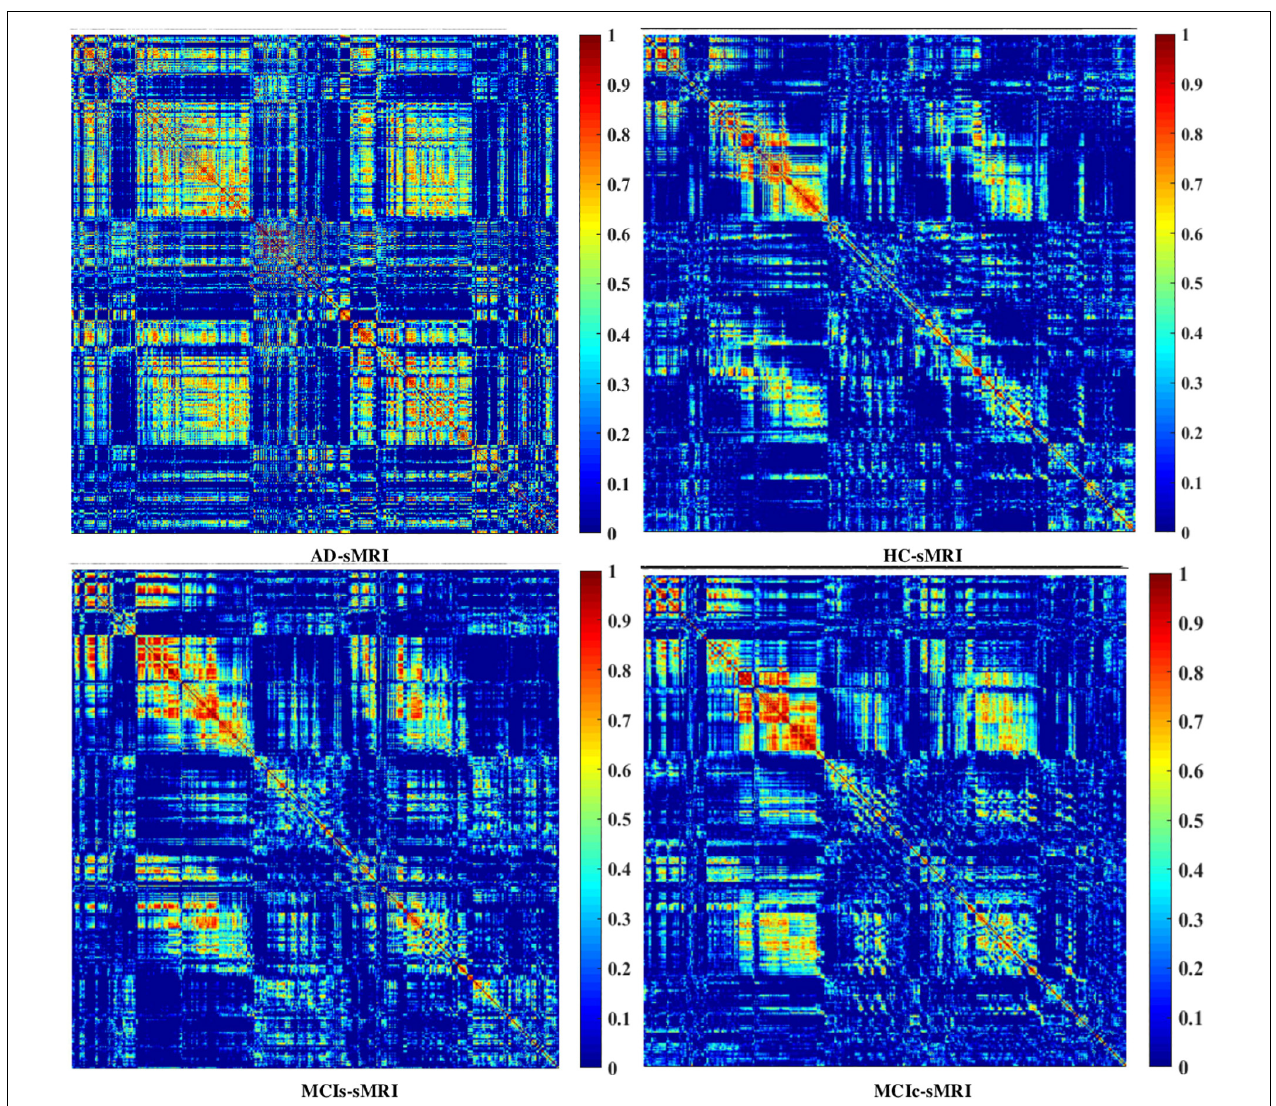
FIGURE 11 | Weighted correlation matrices graph (of 384 regions) for AD, HC, MCIs, and MCIc for sMRI biomarkers.